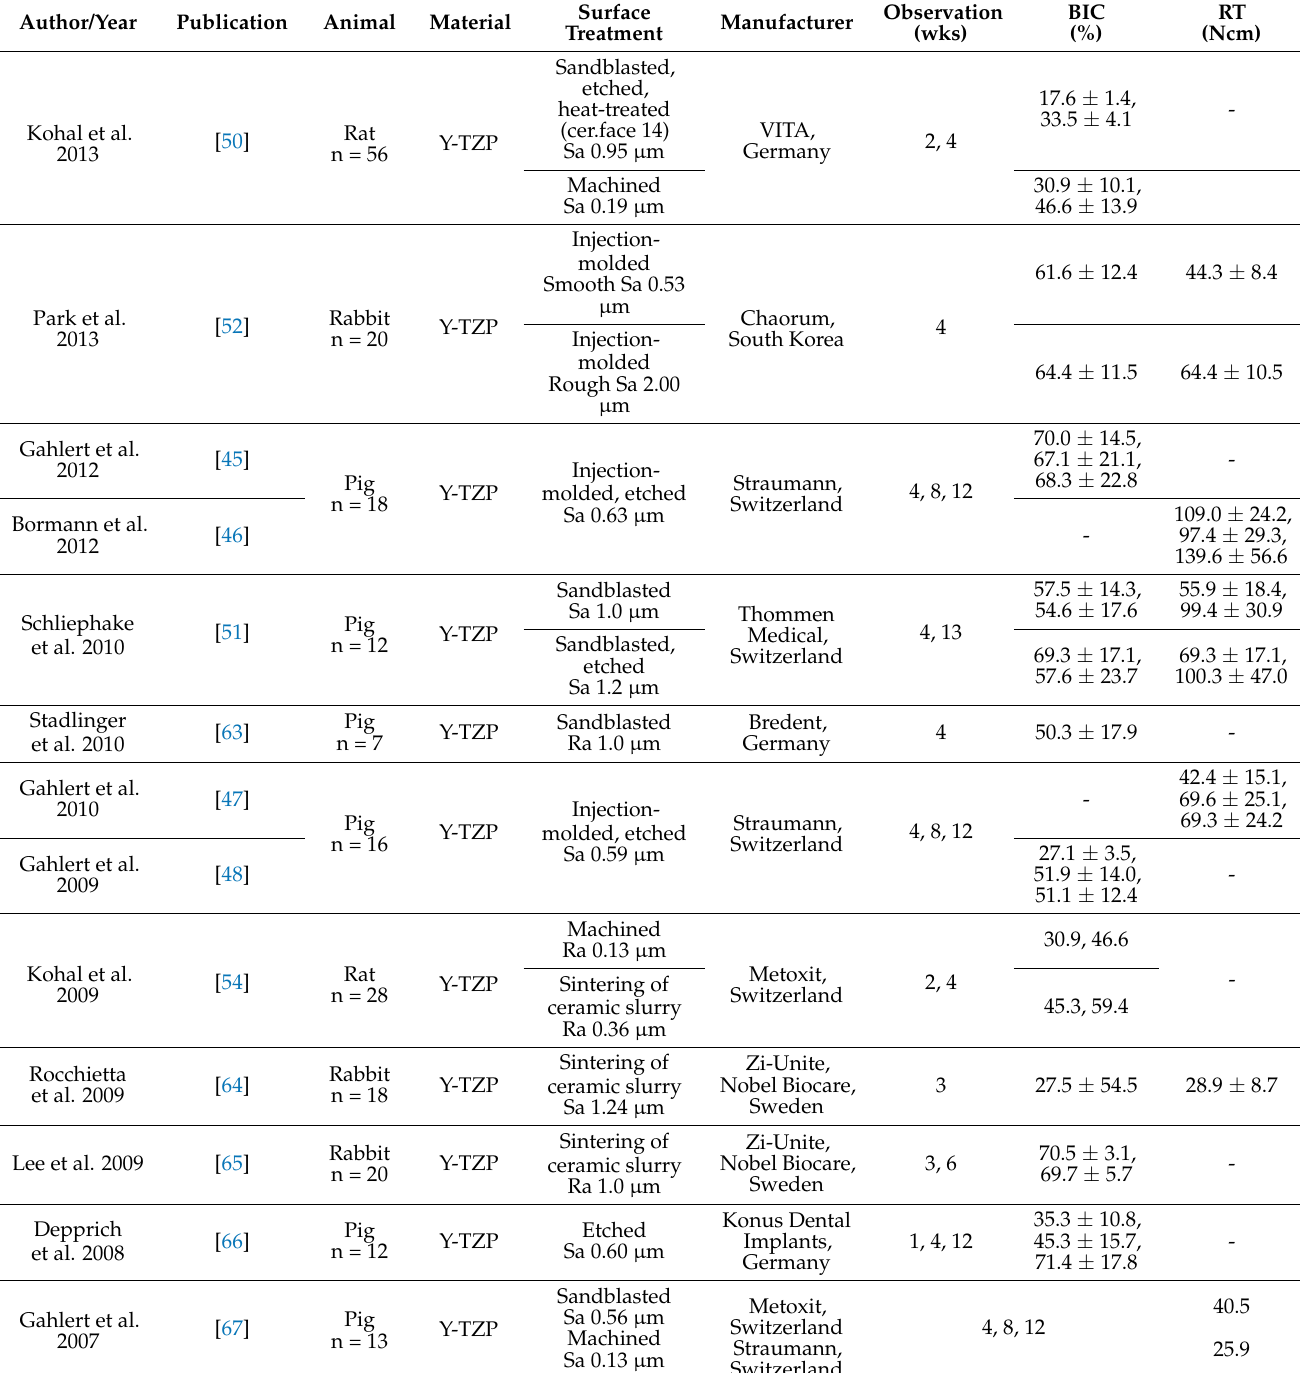
The BIC at the respective intervention time for each study is displayed in Figure 3a. Similar surface treatments were pooled in Figure 3b. No clear preference of one surface treatment is observable. Figure 3c shows the BIC pooled by the animal model for zirconia implants. The rabbit and rat models display a short intervention time with a fast osseointe- gration; however, with the rabbit model, higher BIC values were reported. The BIC with the pig model decreased again after 8 weeks. For the dog model, osseointegration progressed slower and required observation periods of up to 48